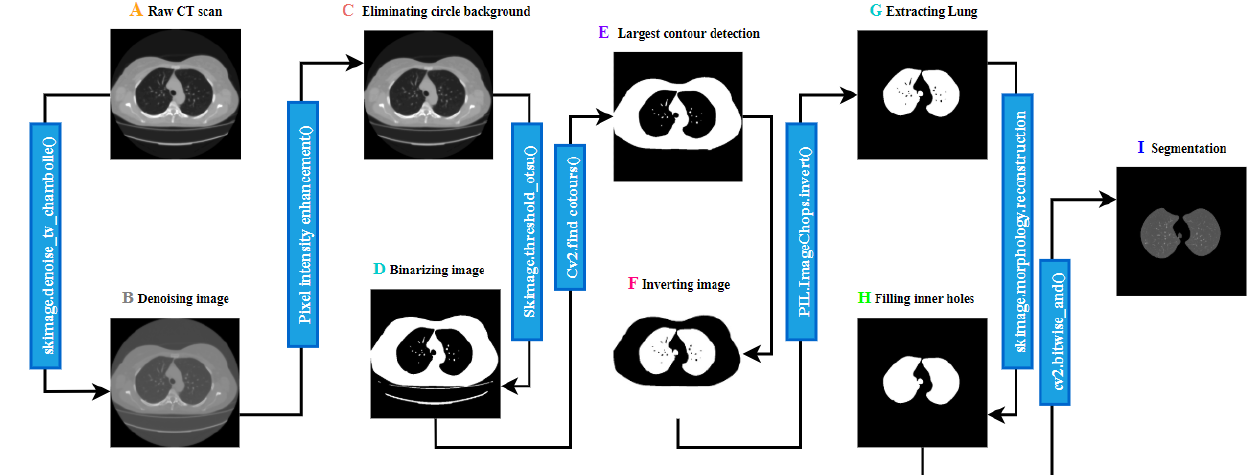
Figure 9. Lung segmentation process.